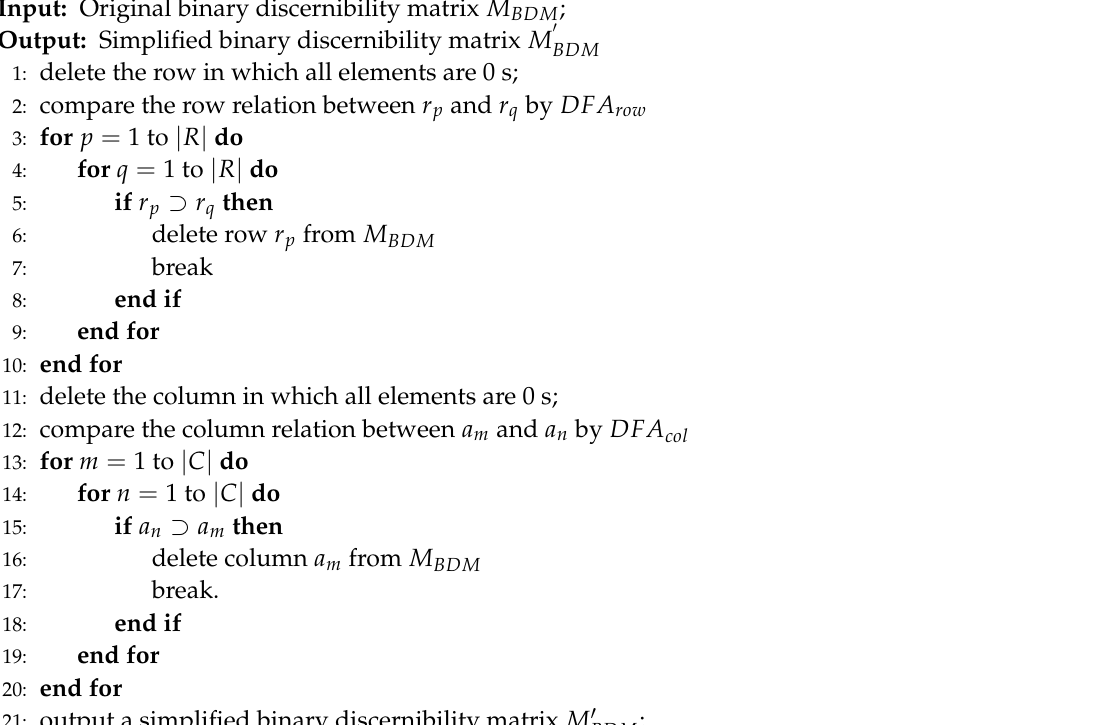
Algorithm 3 : A quick algorithm for binary discernibility matrix simplification using deterministic finite automata, BDMSDFA